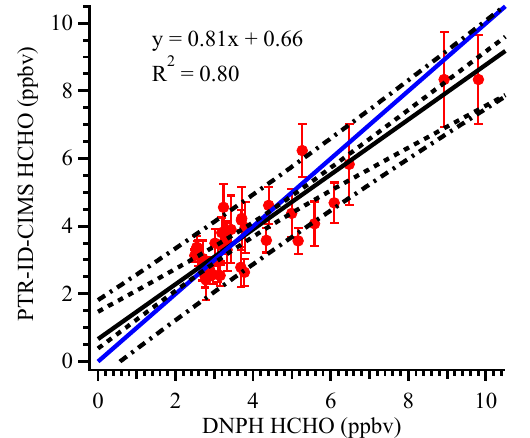
Figure 9. Linear correlation between PTR-ID-CIMS and DNPH measurements of HCHO. The blue trace represents the 1:1 guide- line. The black solid line is the linear fit based on orthogonal dis- tance regression. The dashed line and the dot-dashed line denote the 95% confidence interval band and the 95% prediction band, respectively. The error bars indicate 1 standard deviation of PTR- ID-CIMS data within the corresponding DNPH sample collection